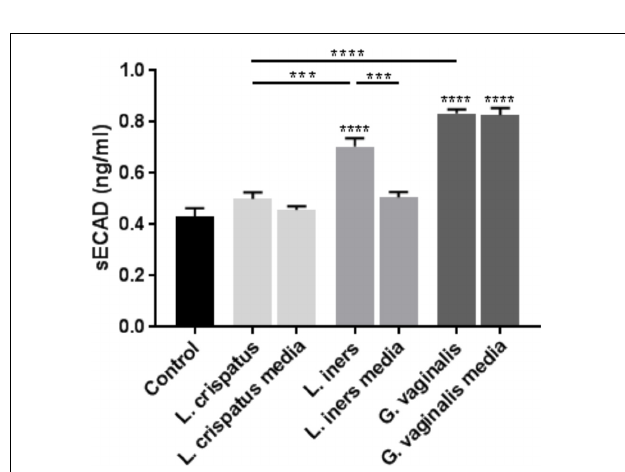
FIGURE 2 | Lactobacillus iners and G. vaginalis but not L. crispatus bacteria-free supernatants increase epithelial-cadherin cleavage in ectocervical cells. Soluble epithelial-cadherin (sECAD) levels were measured after ectocervical cells were exposed to L. crispatus , L. iners , and G. vaginalis bacteria-free supernatants (10% v/v) for 48 h. Bacterial growth media alone acted as a negative control for the three bacteria-free supernatants tested. sECAD was measured in ectocervical cell culture supernatants using a commercially available sandwich ELISA. Values are mean ± SEM. Asterisks over the individual bars represent comparisons to control; asterisks over solid lines represent comparisons between treatment groups. ∗ p < 0.05, ∗∗ p < 0.01, ∗∗∗ p < 0.001, ∗∗∗∗ p <